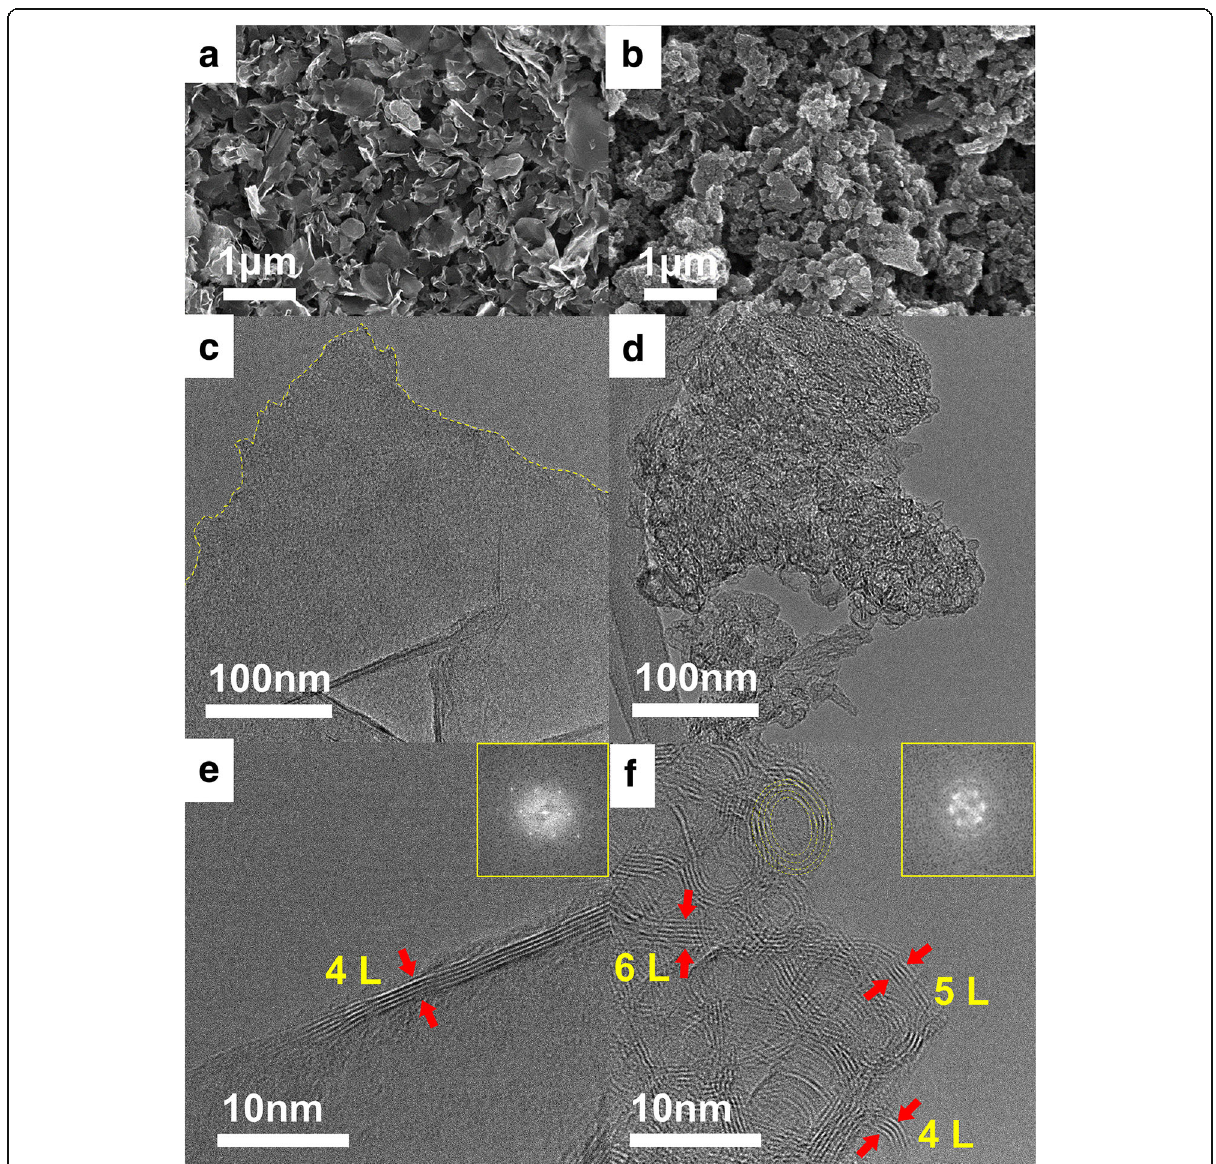
Fig. 2 a , b FESEM images of a GNS_Na + and b GNS_H + ; c , d bright-field TEM images and e , f HRTEM images with corresponding FFT images